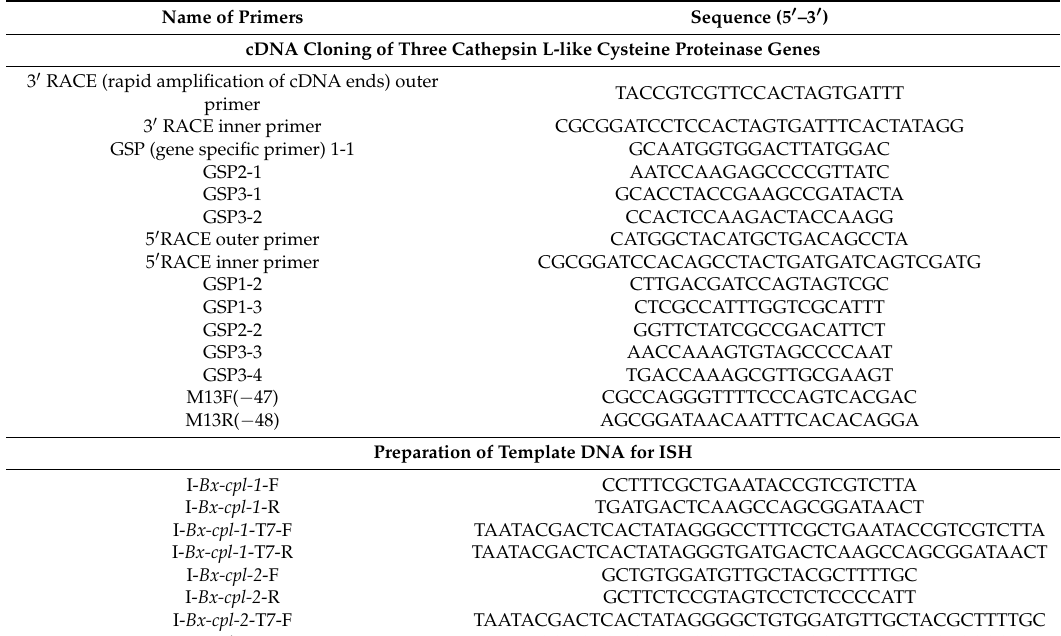
Table 2. Polymerase chain reaction (PCR)